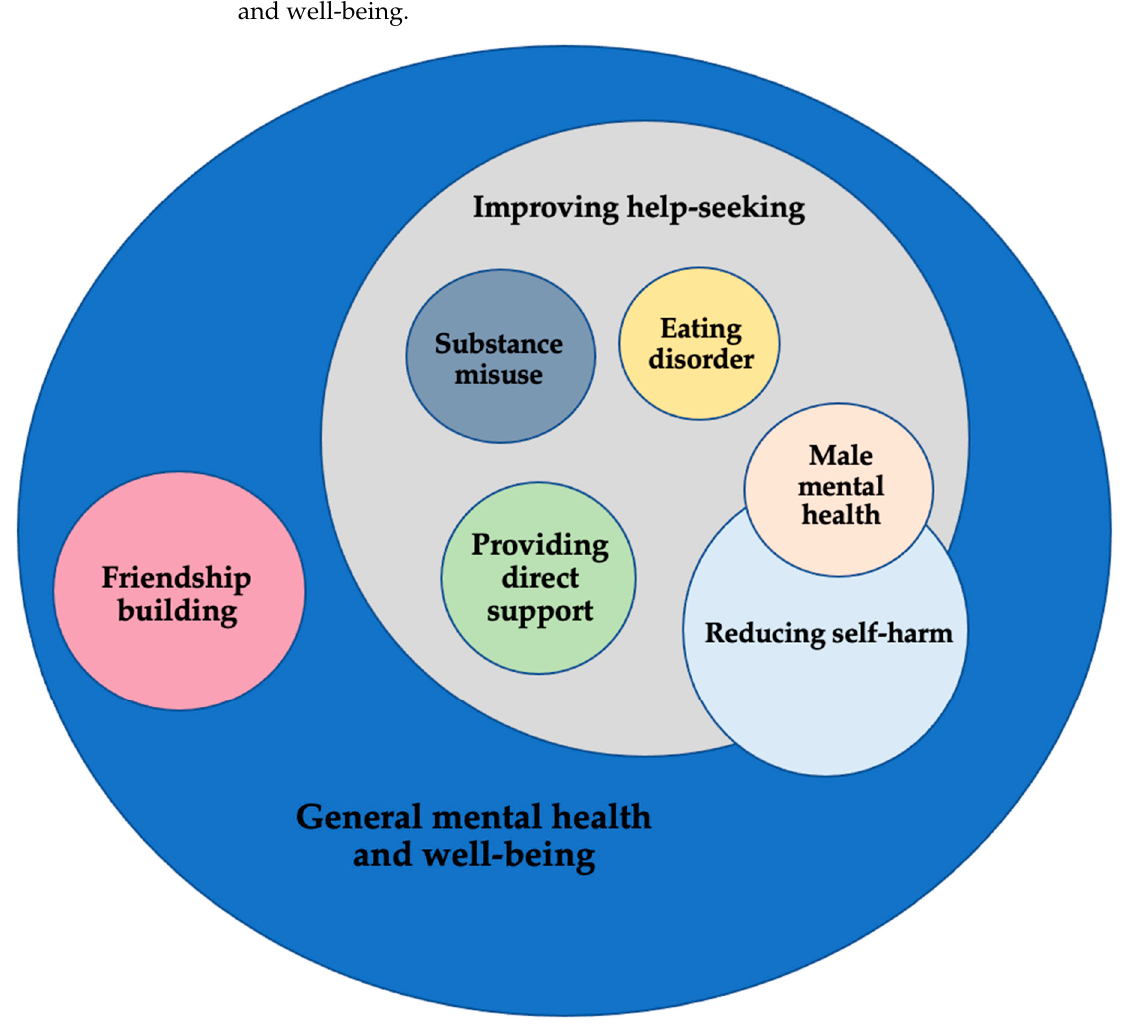
Figure 2. Mapping targets of the included friendship interventions.